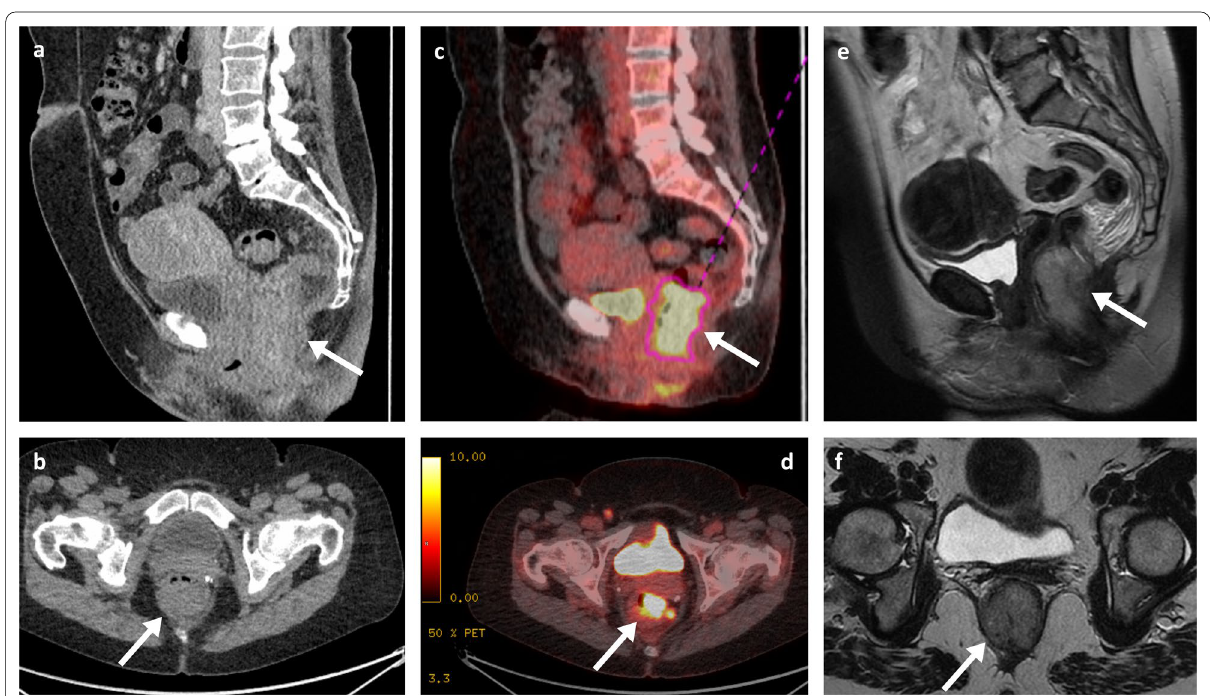
Fig. 10 Portal phase contrast-enhanced CT sagittal ( a ) and axial ( b ), PET-CT sagittal ( c ) and axial ( d ), and MRI T2WI sagittal ( e ) and T2WI axial ( f ) of a 57-year-old female patient with an anorectal metastatic melanoma (arrows) with a craniocaudal length of 5 cm, situated 1.3 cm from the anal verge with involvement of the right internal sphincter